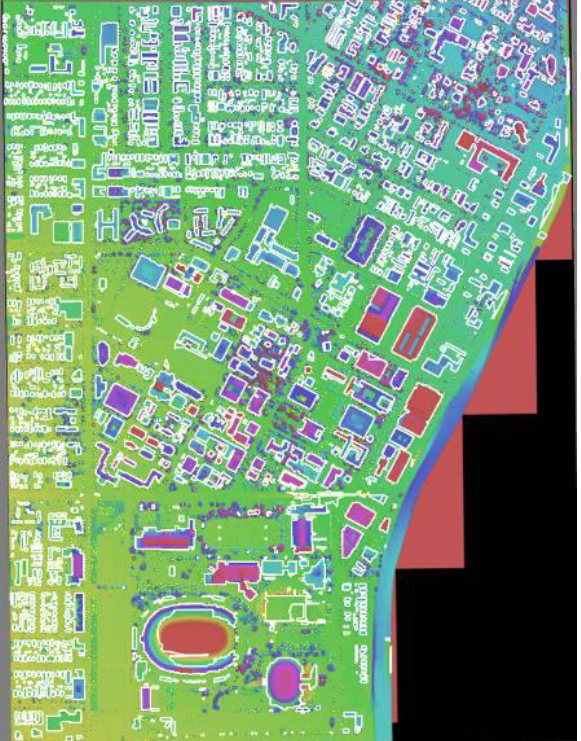
Figure 9. TSR of USC campus covers 24.8 square